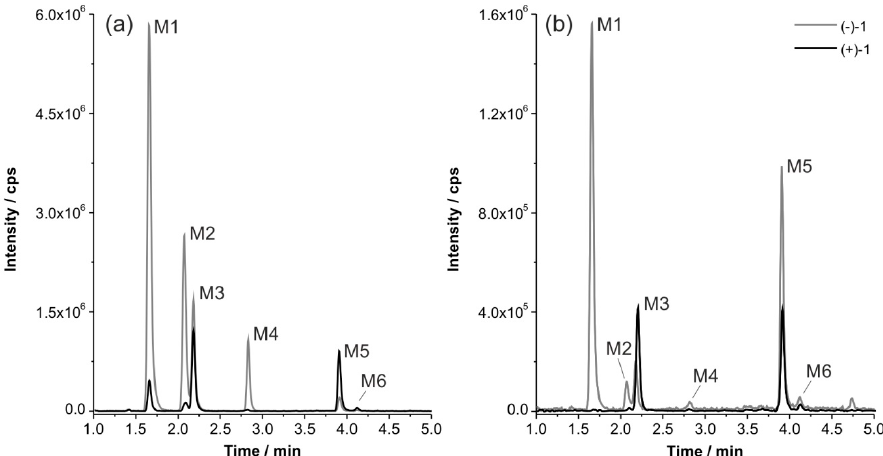
Figure 4. Q3 multiple ion (MI) chromatograms for m / z 223.1 representing monohydroxylated products